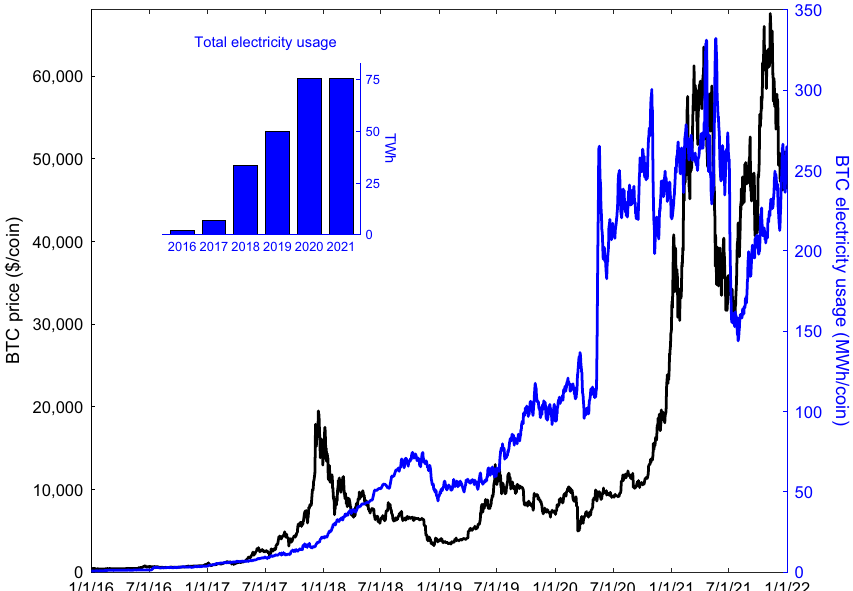
Figure 1. Global 7-days averaged daily electricity usage of mining activity (right axis) and coin exchange price in US$ (left axis) for Bitcoin (BTC). Data from January 1, 2016 to December 31, 2021 shown. Electricity usage is calculated based on network hash rate data downloaded from Blockchain Charts (https:// www. block chain. com/ charts) and mining rig efficiency (see Methods section). Prices downloaded from Yahoo! Finance (https://